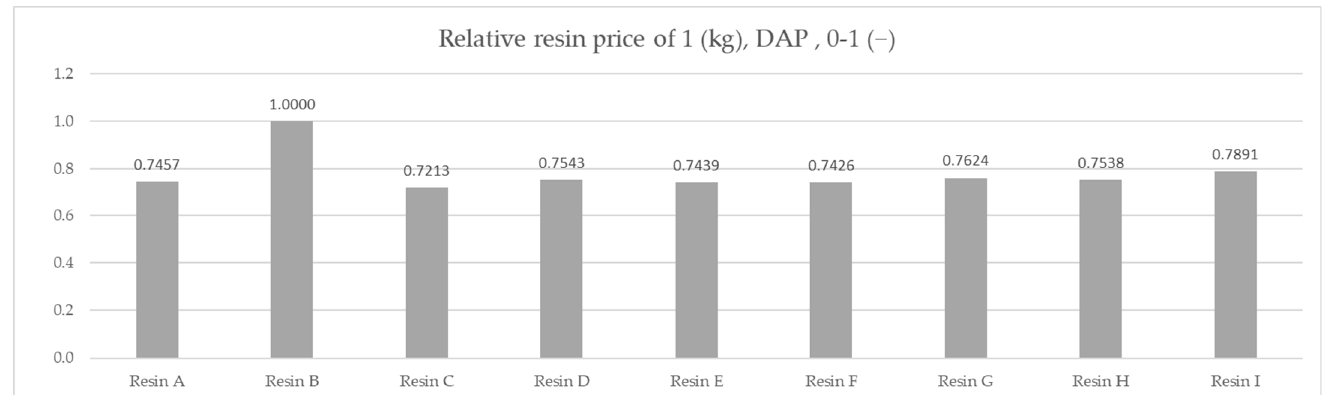
Figure 8. Comparison of the relative cost of 1 kg for resin products under DAP Incoterms.